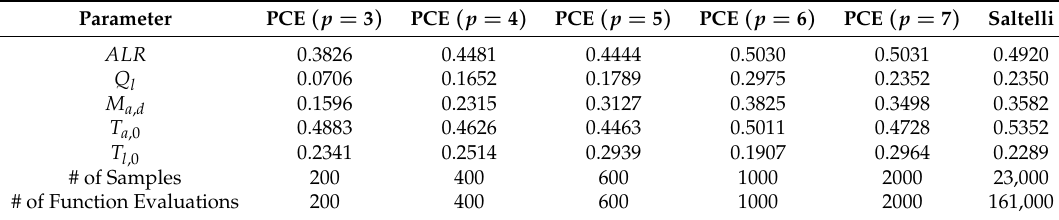
Table 3. Change in total sensitivity indices ( S T , i ) for T p , max with increasing polynomial order ( p ) in the PCE approach.